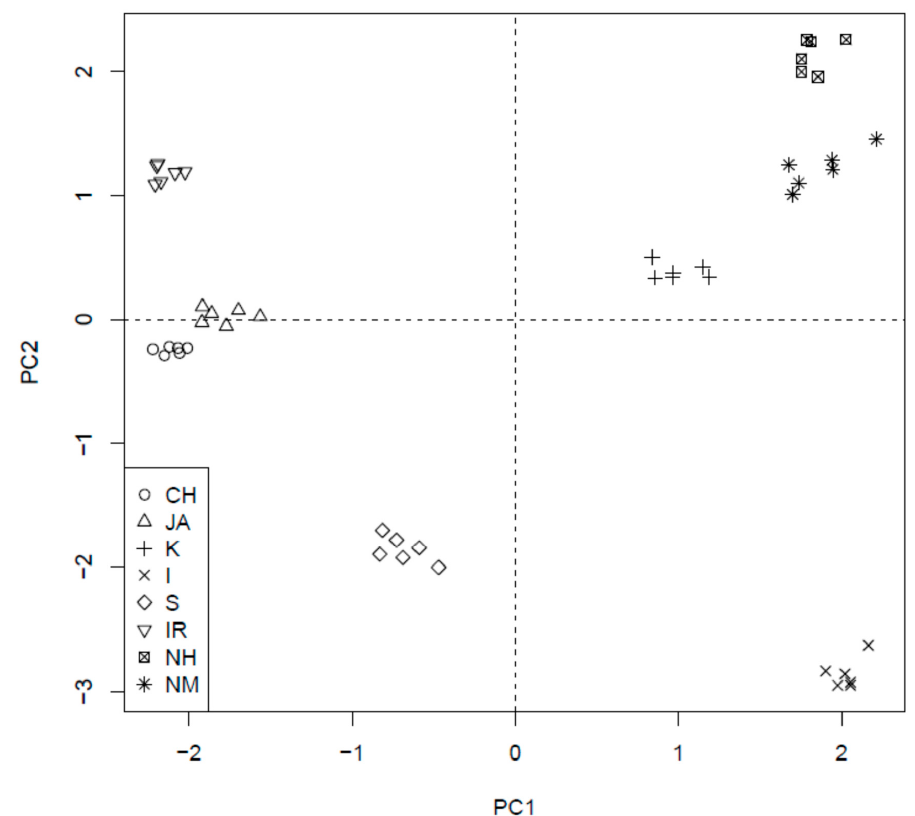
Figure 1. The scores of first two principal components of PCA analysis, explaining together 80% of information in the obtained dataset.